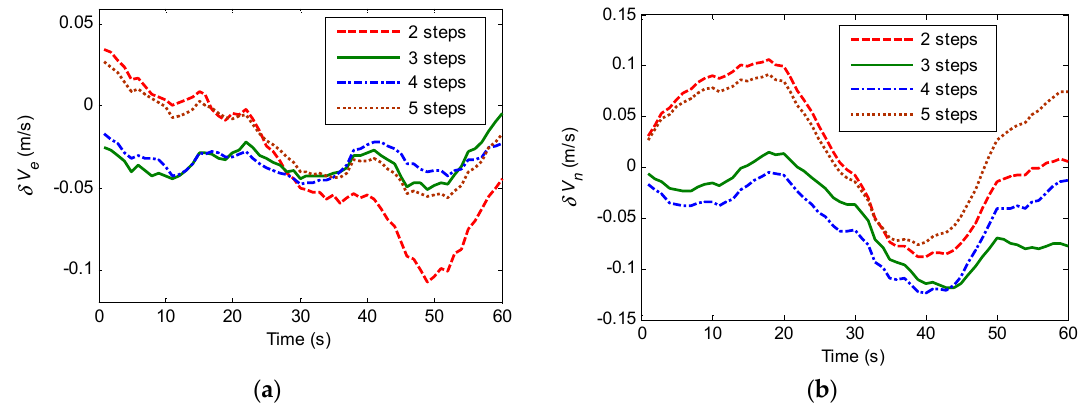
Figure 7. Velocity errors: ( a ) East velocity error; ( b ) North velocity error. Table 3. Evaluation on PLSR predictors of different